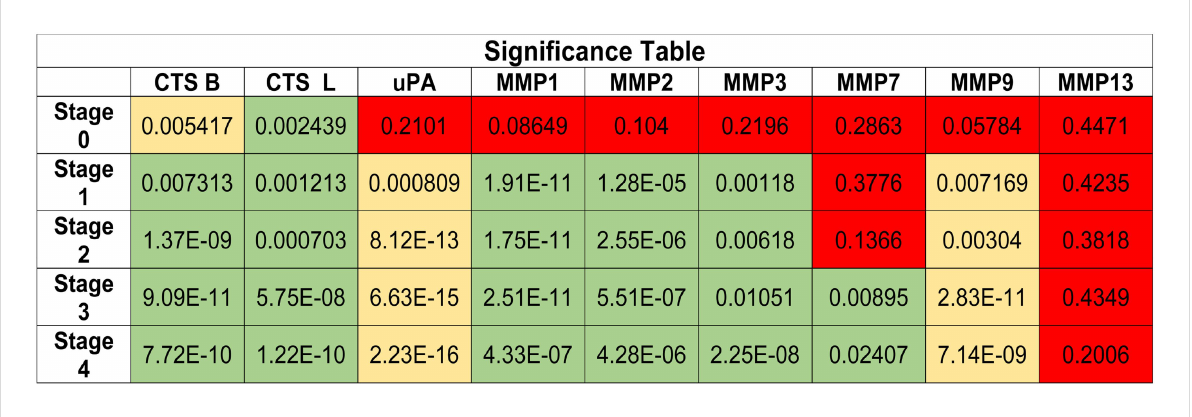
Figure 8: Calculated p -values; comparison of breast cancer patients and healthy human subjects for all investigated enzymes, stages 0–4. Green: fluorescence signal (FS) of cancer patients is significantly larger than of control group (CG); Yellow: FS is significantly smaller; Red: differences in FS and CG are not